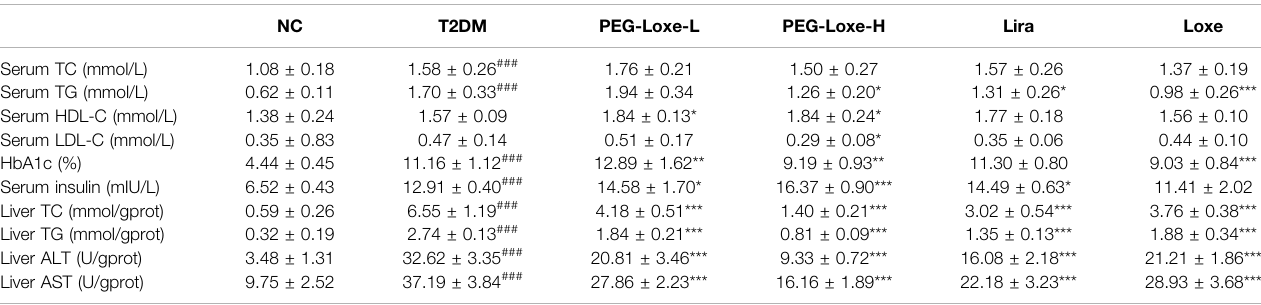
TABLE 1 | PEG-Loxe improved the levels of various biochemical parameters in db/db mice. NC T2DM PEG-Loxe-L PEG-Loxe-H Lira Loxe Serum TC